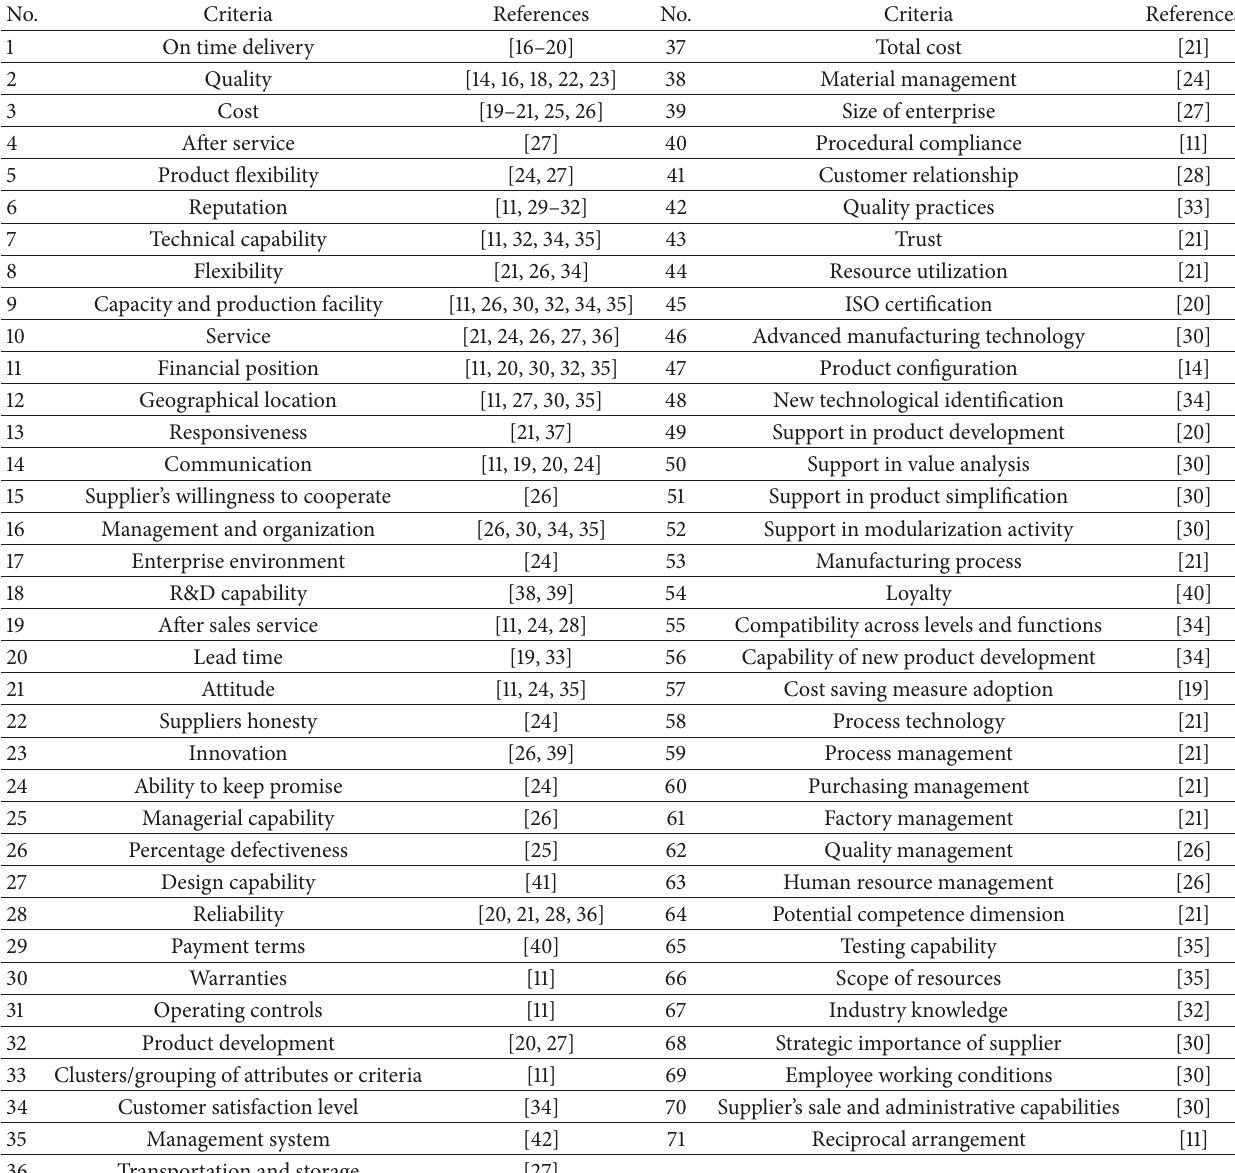
Table 1: Indexes of supplier